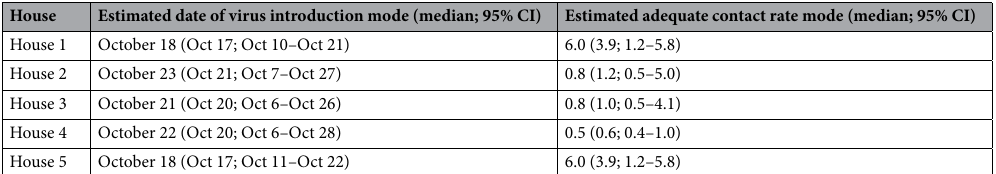
Table 2. Mode, median, and 95% CI for the date of virus introduction and adequate contact rate estimated from each house on Kandiyohi 2.